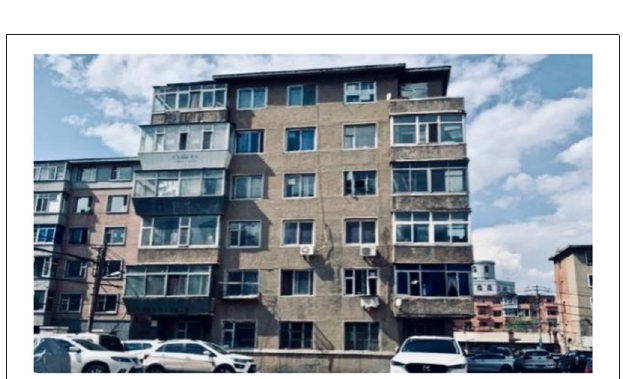
FIGURE 6 | Lianhua Mountain Shimao real estate (b) (Source: